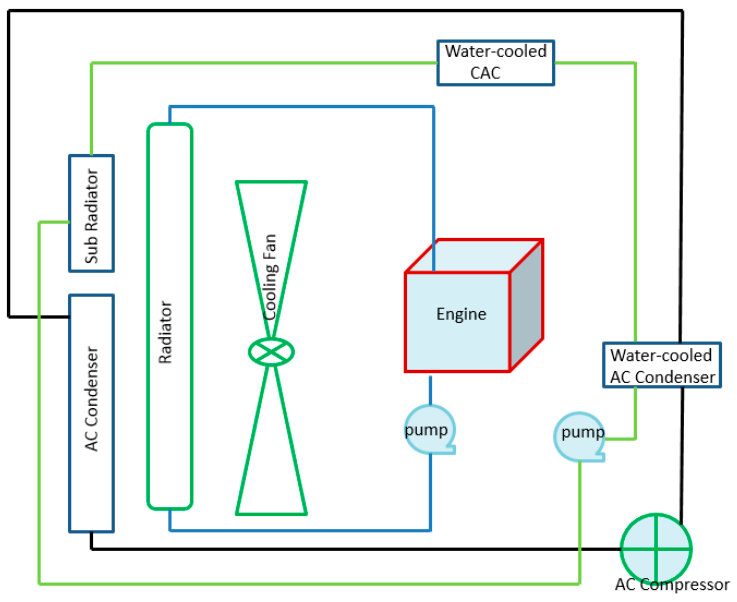
Figure 5. Schematic diagram for the “SLIM” ITM [78].